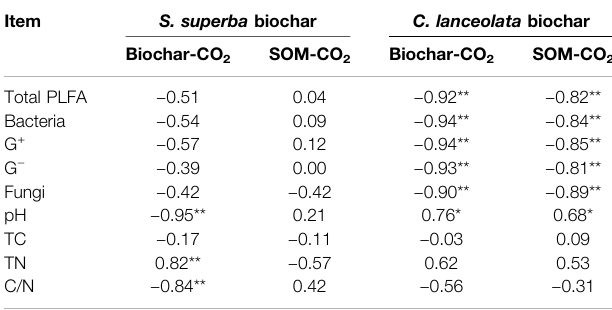
TABLE 2 | Correlation coef fi cients between the cumulative CO 2 and the microbial PLFA content or soil properties ( n (cid:2) 9).